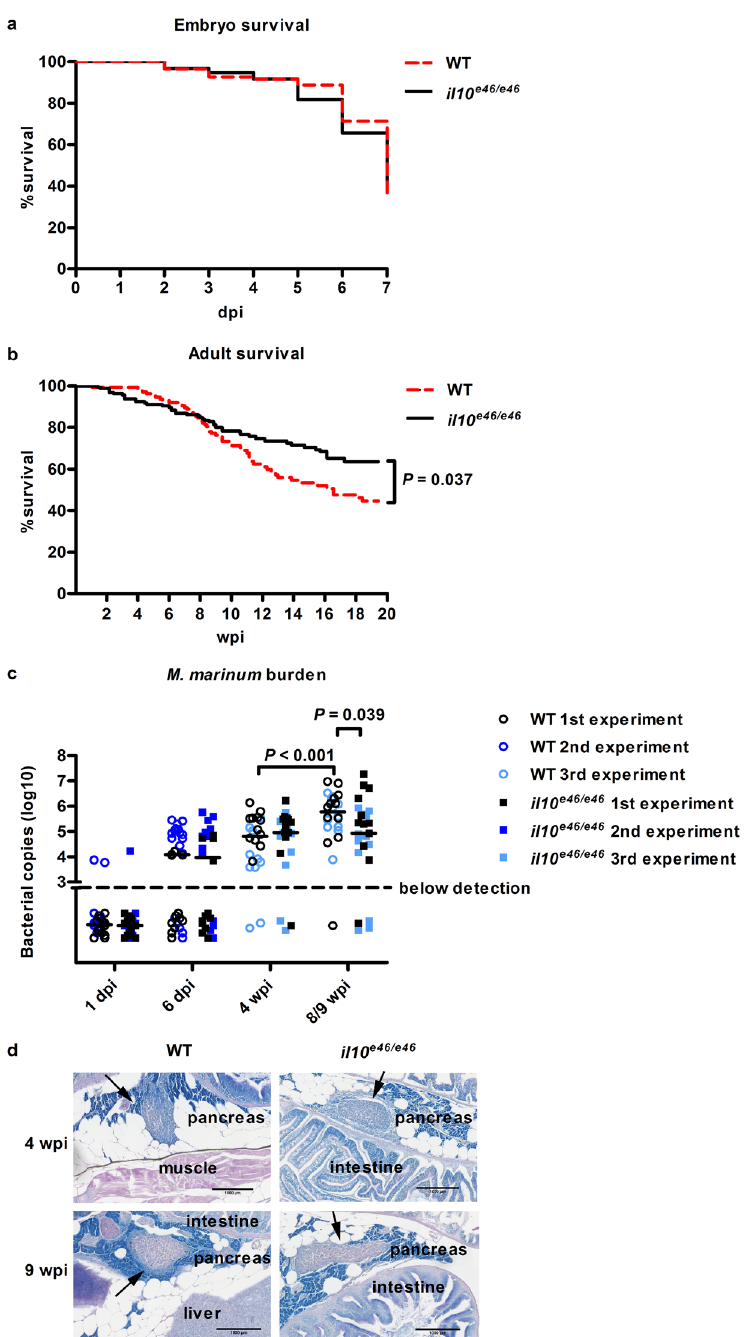
Figure 3. Adult il10 e46/e46 zebrafish have enhanced survival compared to WT controls in a low-dose M. marinum infection. ( a ) il10 e46/e46 ( n = 158) and WT ( n = 181) zebrafish larvae were microinjected before 6 hours post fertilization with M. marinum (3–29 CFU) and their survival was monitored for 7 days. The experiment was done six times and the data presented here is collected from one representative experiment. ( b ) The survival of adult il10 e46/e46 ( n = 172) and WT ( n = 149) zebrafish was monitored for 16–20 weeks after a low-dose (2–156 CFU) mycobacterial infection. The data were collected from four experiments. ( c ) The M. marinum burden in abdominal organ blocks (including kidney in the first and the second experiment, without kidney in the third experiment) of adult il10 e46/e46 mutant zebrafish ( n = 22–27) and WT controls ( n = 22–30 fish) was quantified with qPCR at 4 and 8/9 weeks post a low-dose infection (1–18 CFU). The bacterial load is presented as a scatter dot plot and as the median of total bacterial copies (log 10 ). The data were collected from three experiments. ( d ) M. marinum granulomas were detected with Ziehl-Neelsen staining ( n = 4 in both groups at both time points) at 4 and 9 weeks post a low-dose infection (2–9 CFU). Representative individuals from each group are shown. Granulomas are indicated with arrows. For panels (a) and (b) a log-rank (Mantel-Cox) and for panel (c) A two- tailed Mann-Whitney test was used for the statistical comparison of